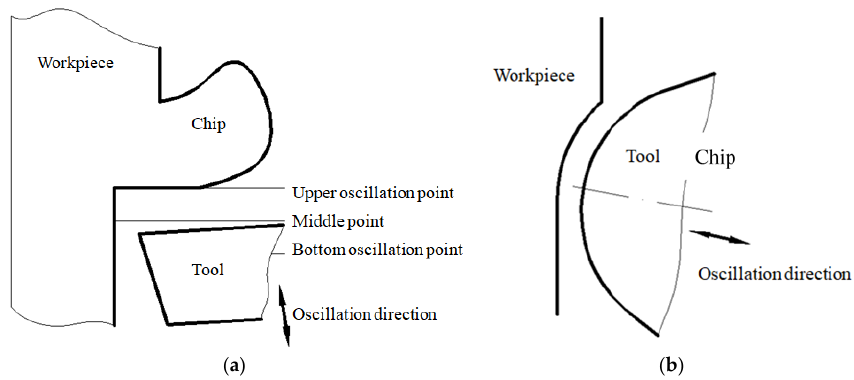
Figure 15. Schematic diagram of inclined ultrasonic vibration cutting with negative rake angle; ( a ) Front view; ( b ) Top view.